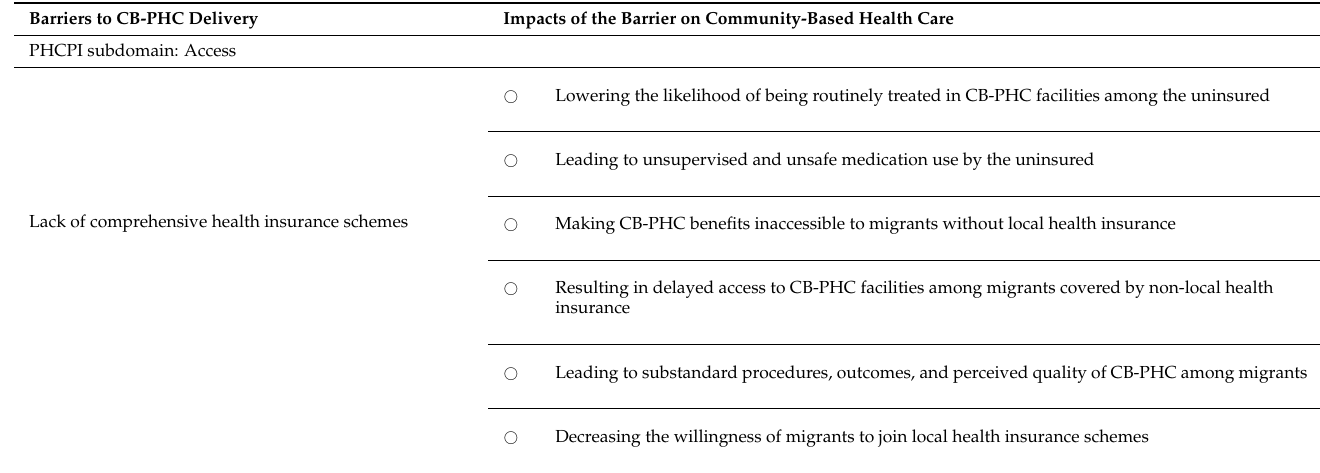
Table 3. Barriers to CB-PHC delivery and their impacts on community-based health care in urban China identified by this